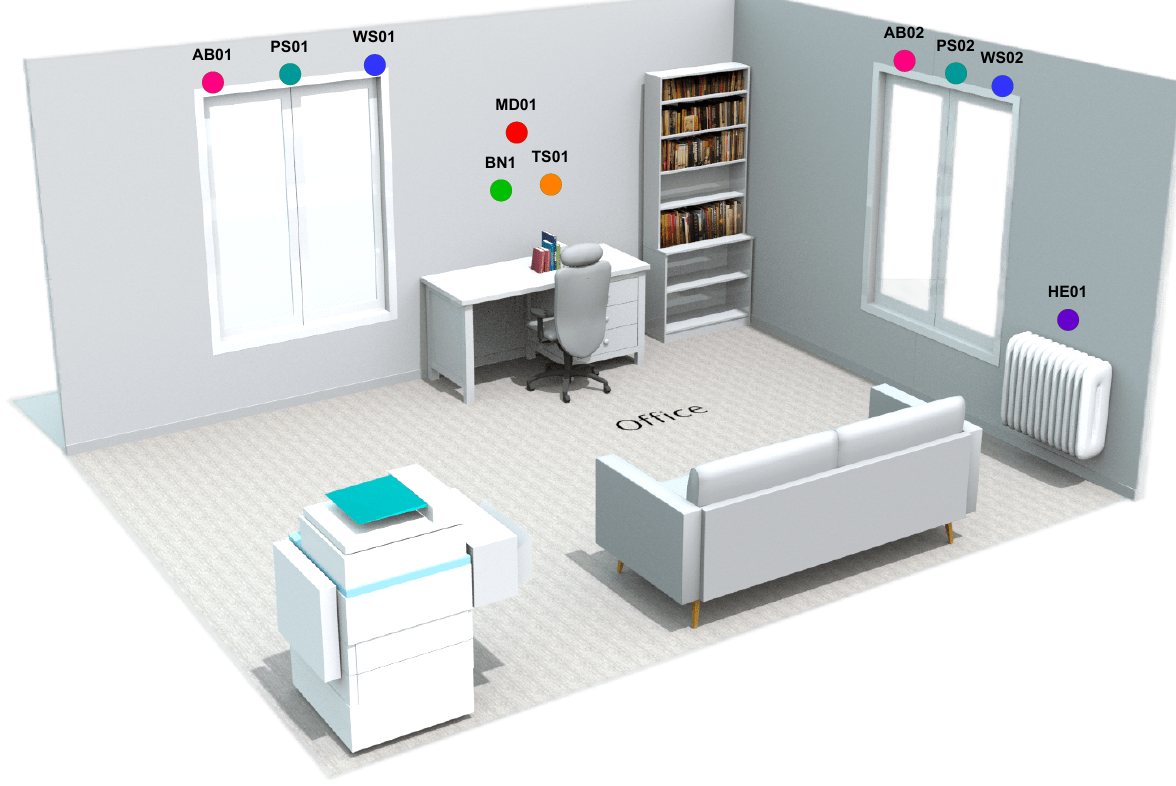
Figure 17. Overview of the sensors and actuators in the smart office